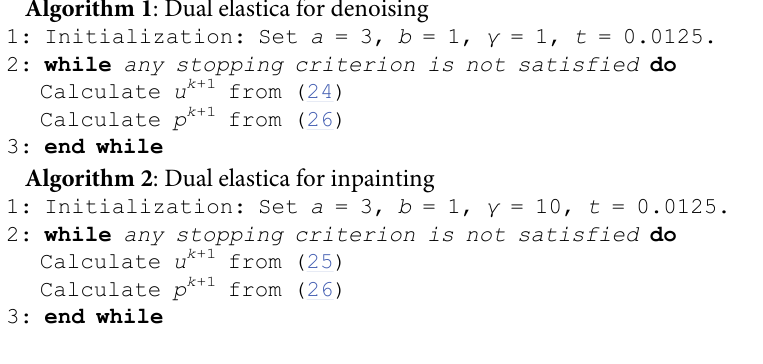
Algorithm 1 : Dual elastica for denoising